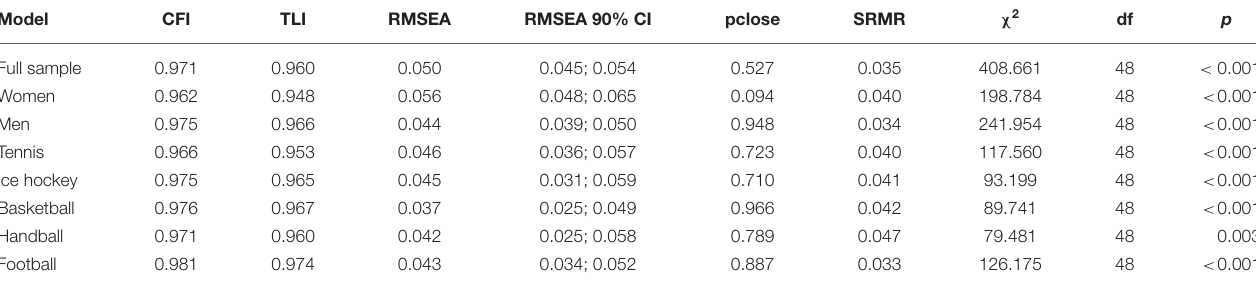
TABLE 5 | Fit indexes of the estimated structural equation models.